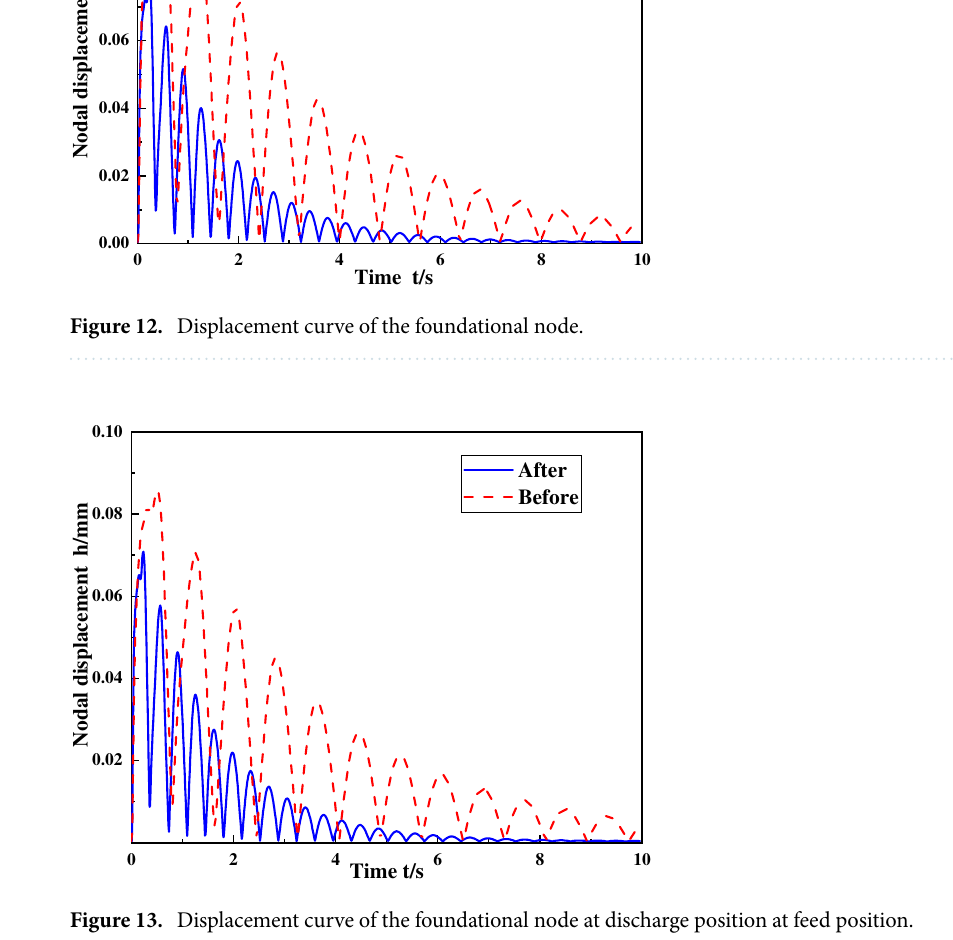
Figure 13. Displacement curve of the foundational node at discharge position at feed